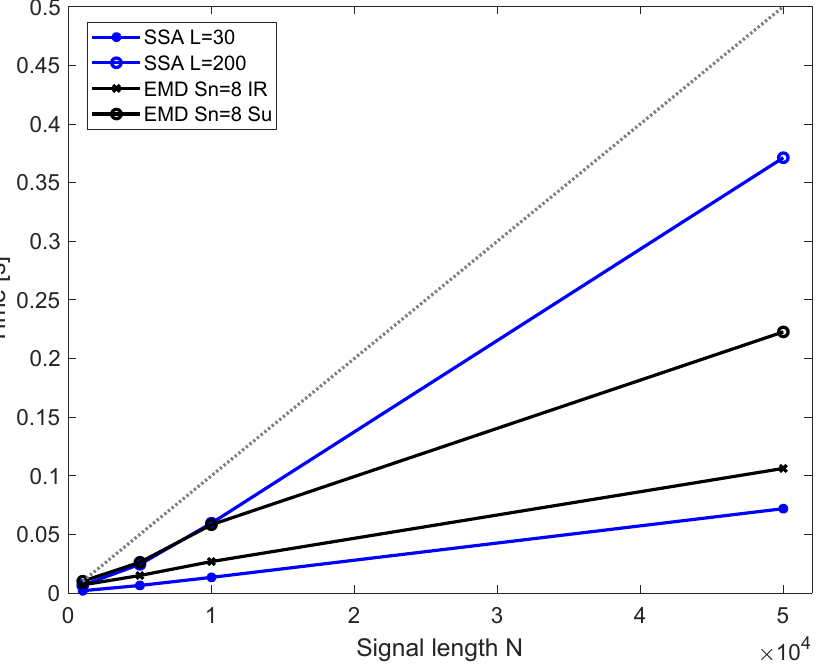
Figure 14. Time of obtaining the components with EMD and SSA for selected parameters for EMD and SSA; dotted line represents the time needed for acquisition of N data